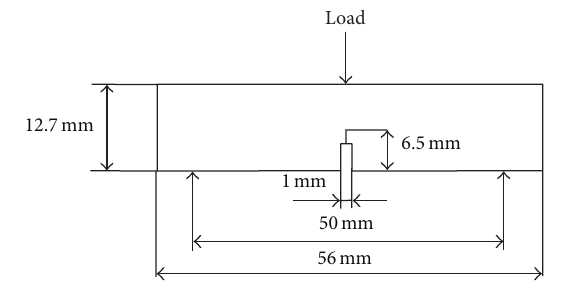
Figure 1: SEN-3PB specimen geometry used for the fracture toughness test.